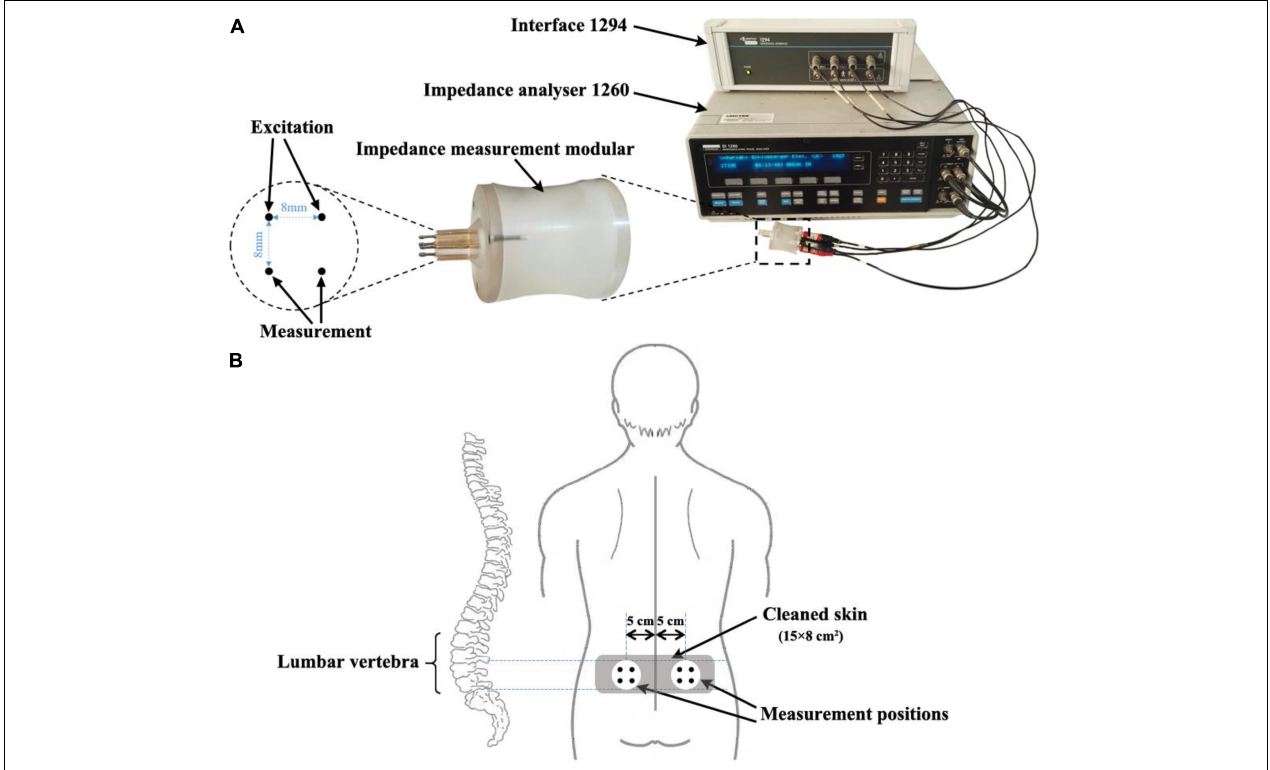
FIGURE 1 | Impedance measurement system and schematic diagram of measurement positions. (A) Impedance measurement system consists of an impedance analyzer (Solartron 1260), a measurement interface (Solartron 1294) and a measurement module developed by our group. (B) Schematic diagram of measurement positions: the impedance measurement module was placed between L4-5 with its center 5 cm from each side of the spine.